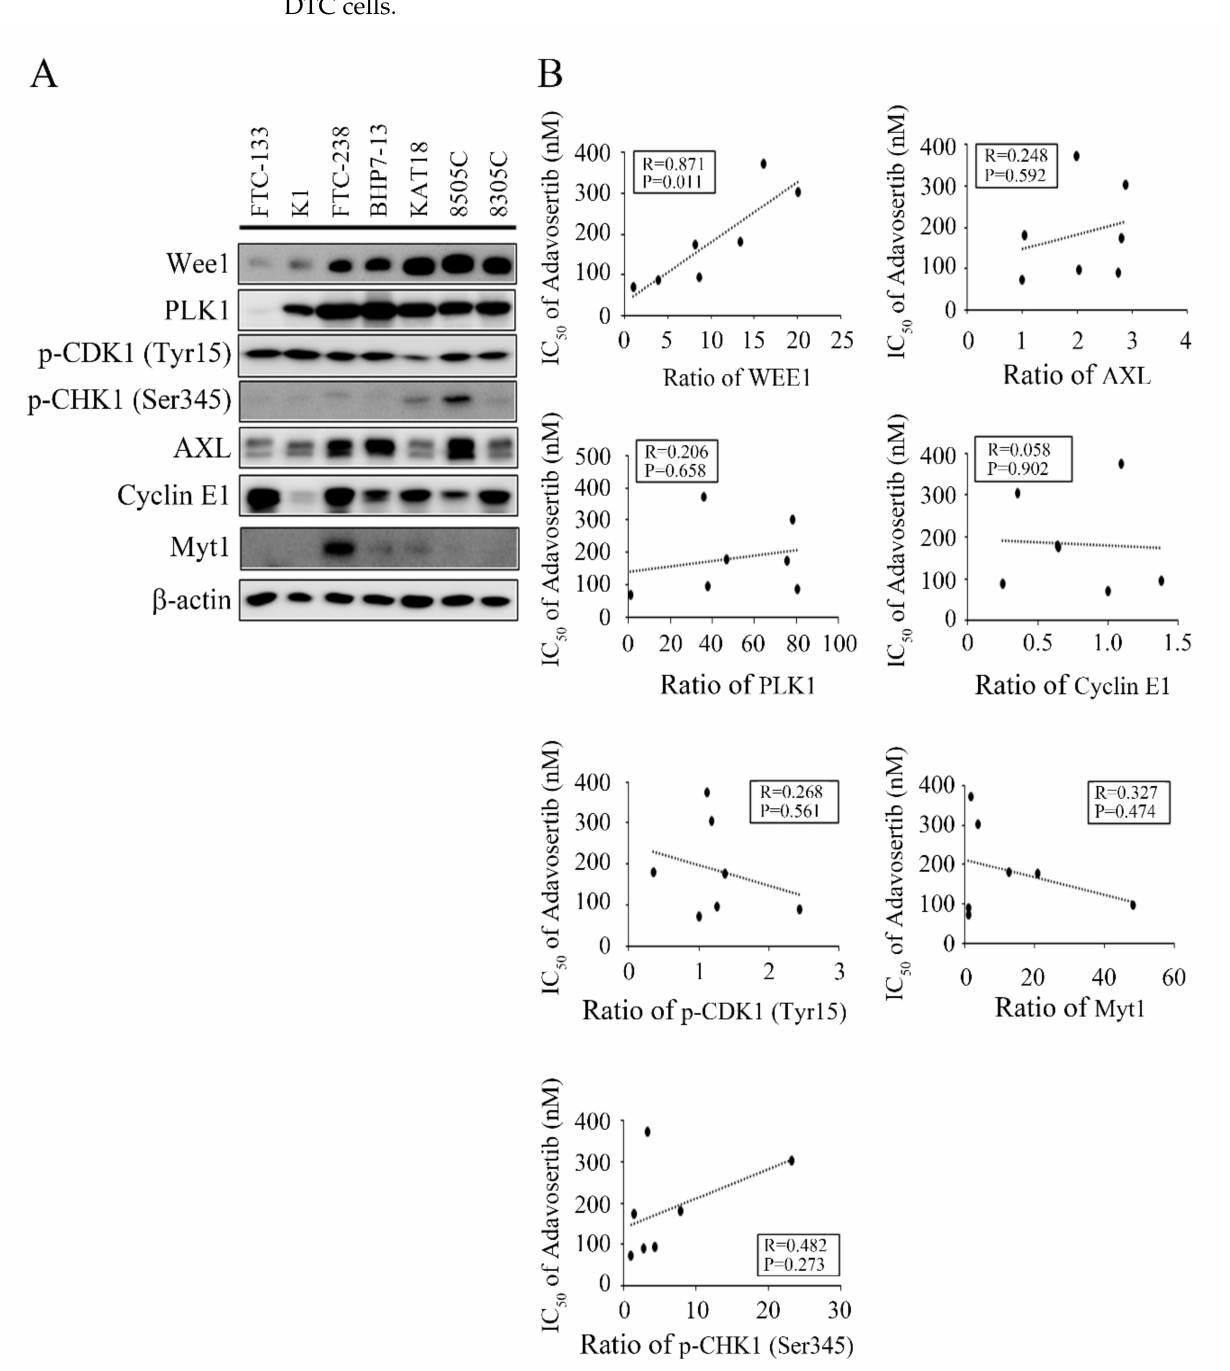
Figure 4. Susceptibility to adavosertib reversely correlates with baseline Wee1 levels. ( A ) The baseline expression of Wee1, PLK1, p-CDK1 (Tyr15), p-CHK1 (Ser345), AXL, cyclin E1, and Myt1 were evaluated by western blot. The loaded proteins were ordered according to the IC 50 of adavosertib in seven thyroid cancer cell lines. Wee1 expression gradually increased from FTC-133 to 8305C; the expression of the other proteins demonstrated a random distribution. ( B ) Band densities were photographed and quantified. The relationships between IC 50 and protein level were analyzed using Pearson’s correlation coefficients, and graphs were created using FTC-133 as reference. Wee1 expression had an inverse correlation with sensitivity to